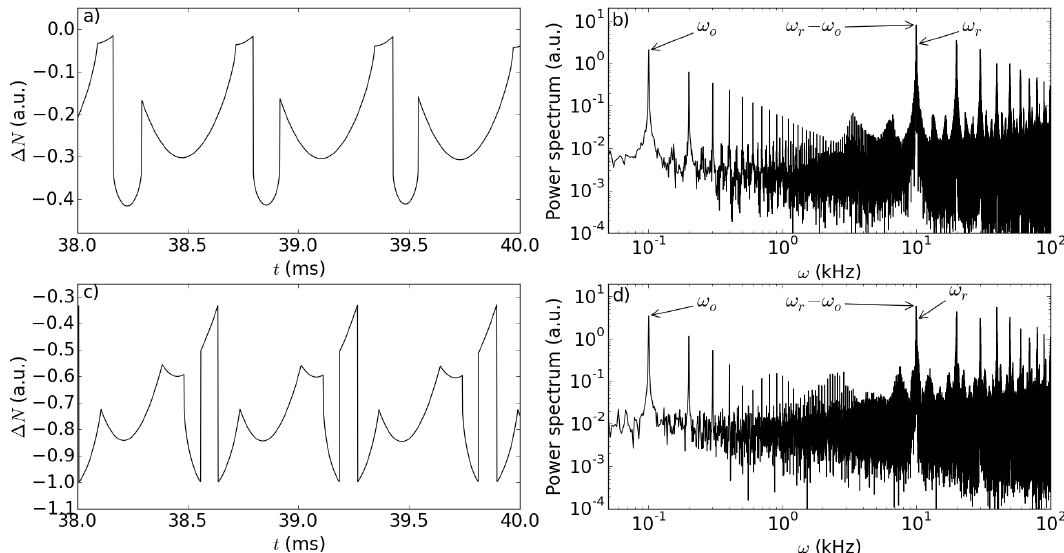
Figure 8. Plot of ∆ N as a function of t ( a , c ) along with their corresponding Fourier transforms plotted in a log-log plane ( b , d ); upper part: k /k The ratio k remains fixed. The other parameters are as in Figure r o